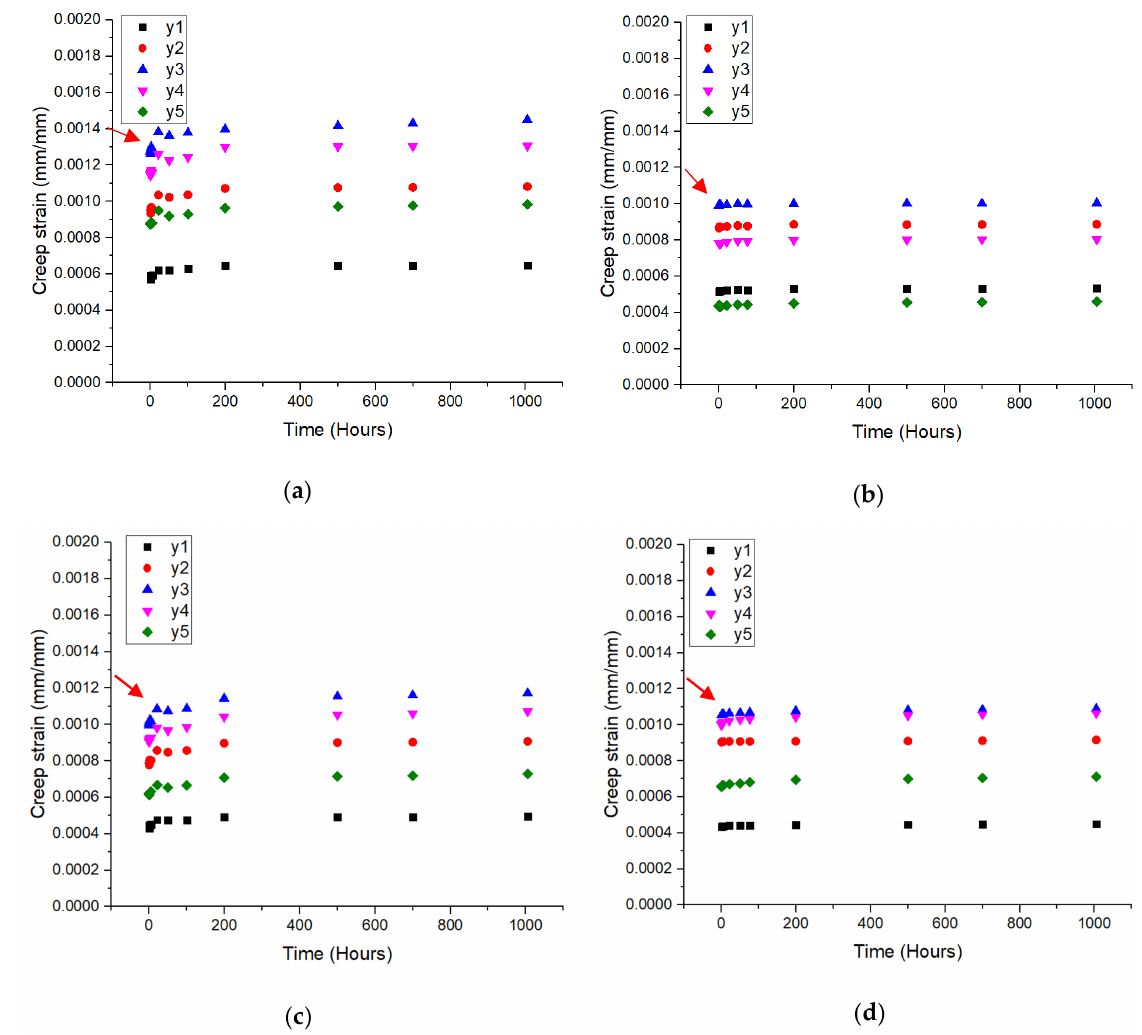
Figure 8. Creep strain-time curves for current PGFRPC cross-arm for ( a ) left and ( c ) right; braced PGFRPC cross-arm for left ( b ) and right ( d ) main